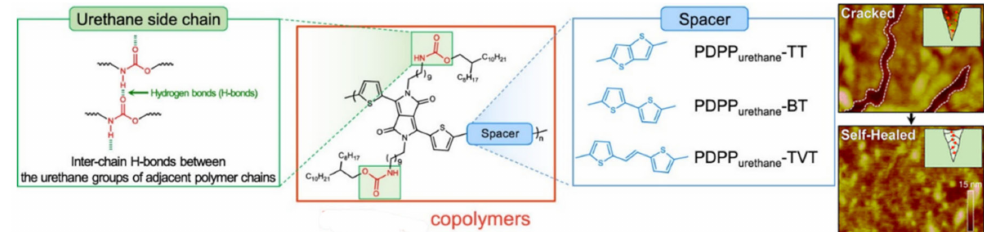
Figure 19. Molecular structures of the copolymers and images of cracked and self-healed samples. Reprinted with permission from [149]. Copyright (2020) American Chemical Society.